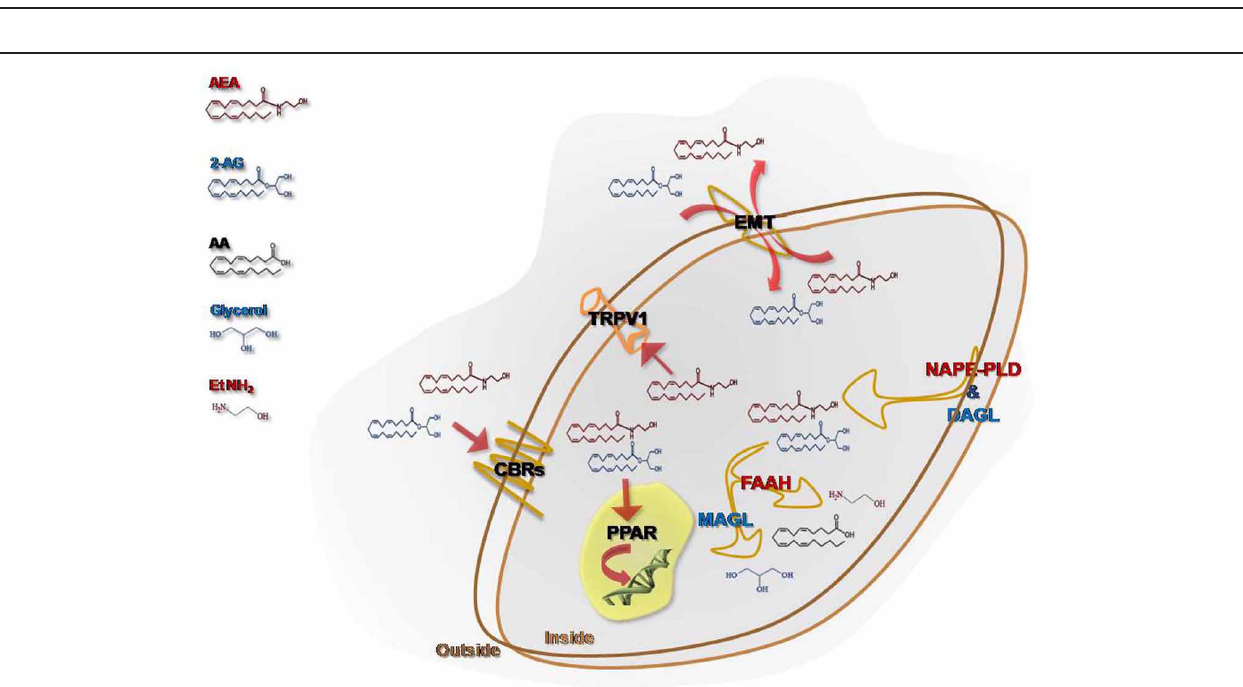
hydrolyzed by a cytosolic monoacylglycerol lipase (MAGL) that releases glycerol and AA. A purported endocannabinoid membrane transporter (EMT) clears AEA and 2-AG from the extracellular space, and takes them up into the cell. Both AEA and 2-AG trigger several signal transduction pathways by acting at their targets, CB 1 , CB 2 , GPR55, and nuclear PPARs. AEA, but not 2-AG, binds intracellularly also TRPV1, and thus it is also designated as a true